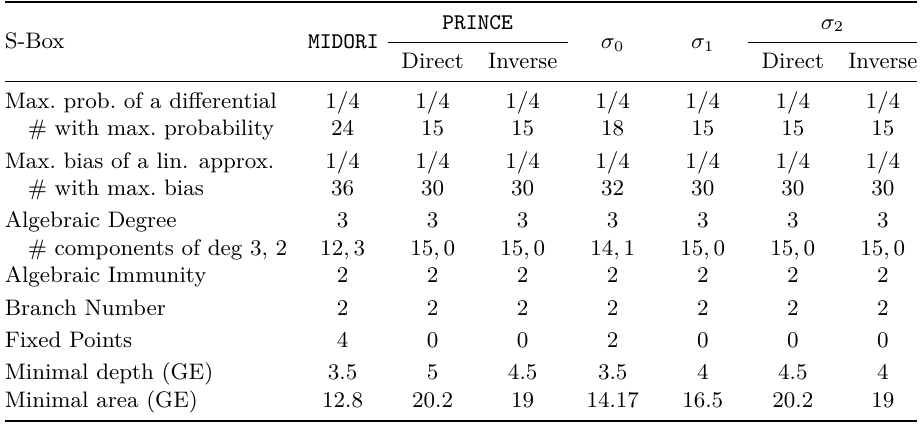
Table 4: Summary of Properties of the MIDORI , PRINCE and QARMA